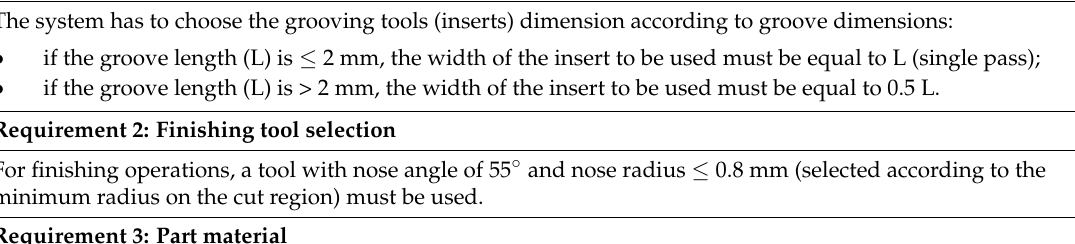
Table 1. Requirement examples.